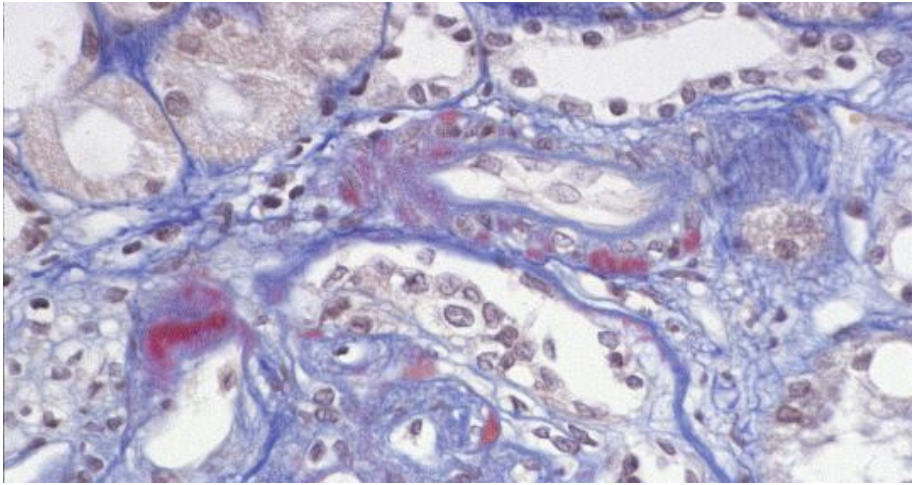
Figure 2. Light microscopy: AFOG stain. Nodular hyaline material is present in the outer media of some arterioles in a patient treated with calcineurin inhibitors.